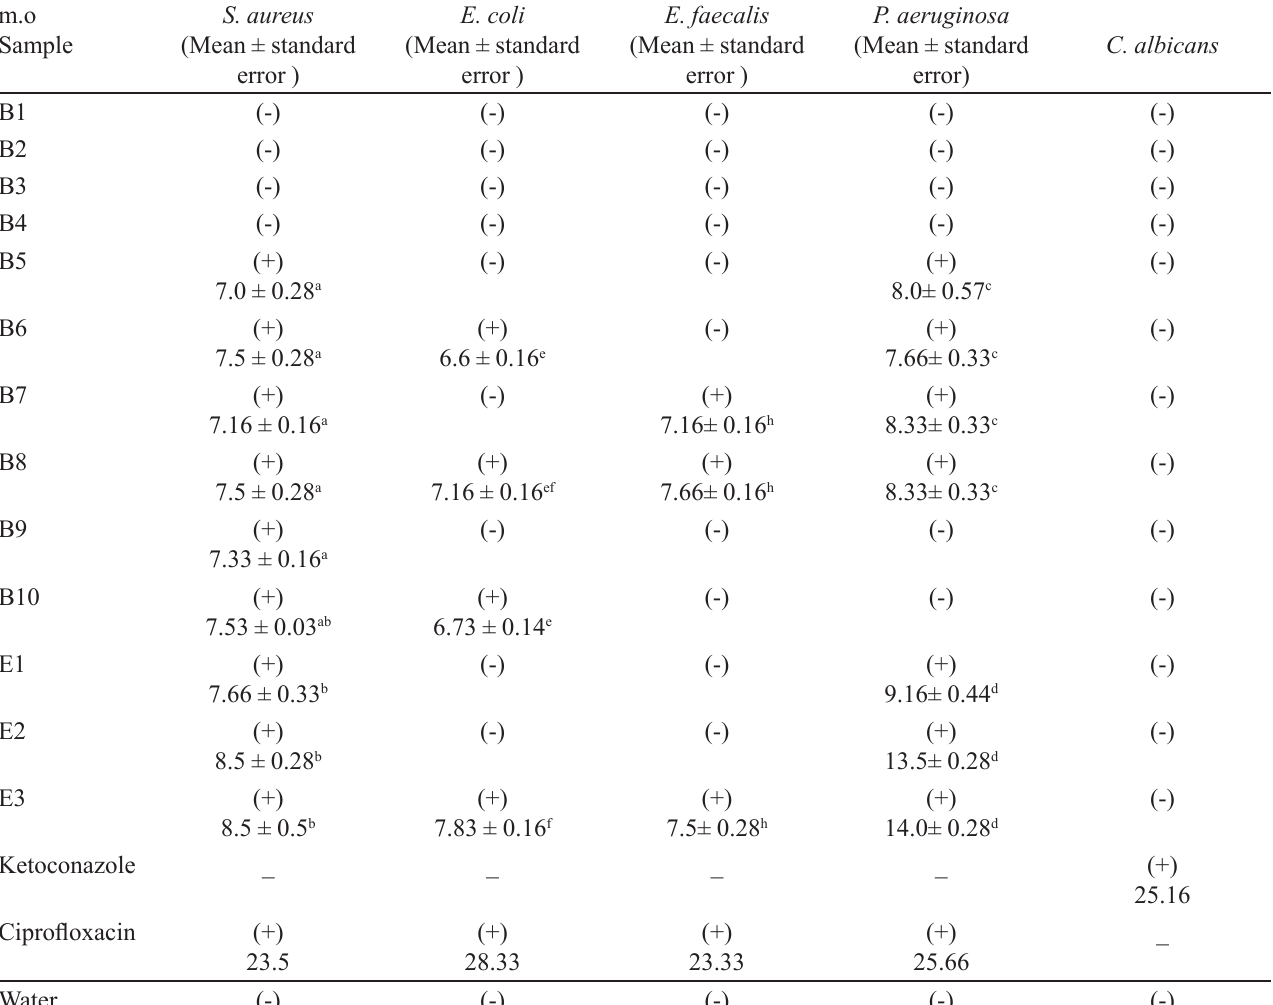
TABLE I - Determination of antimicrobial activity: Mean values of the inhibition zones for positive results